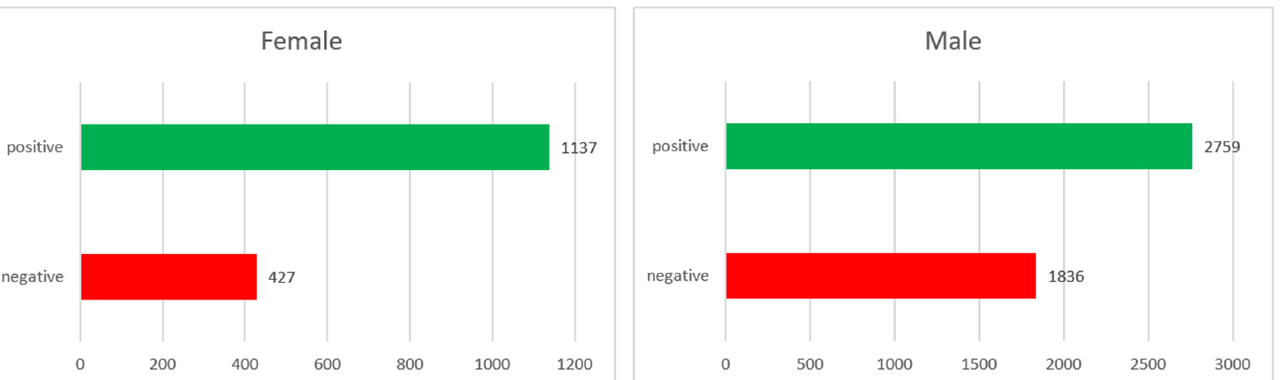
Table 4. Categories and subcategories of topics used for tagging the users’ comments.